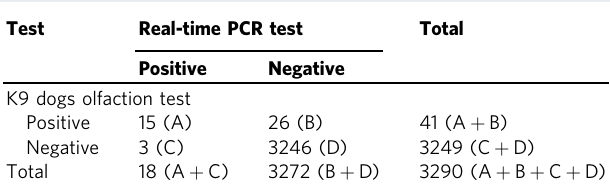
Table 1 Cross-tabulation between RT-PCR and the K9 dogs olfaction